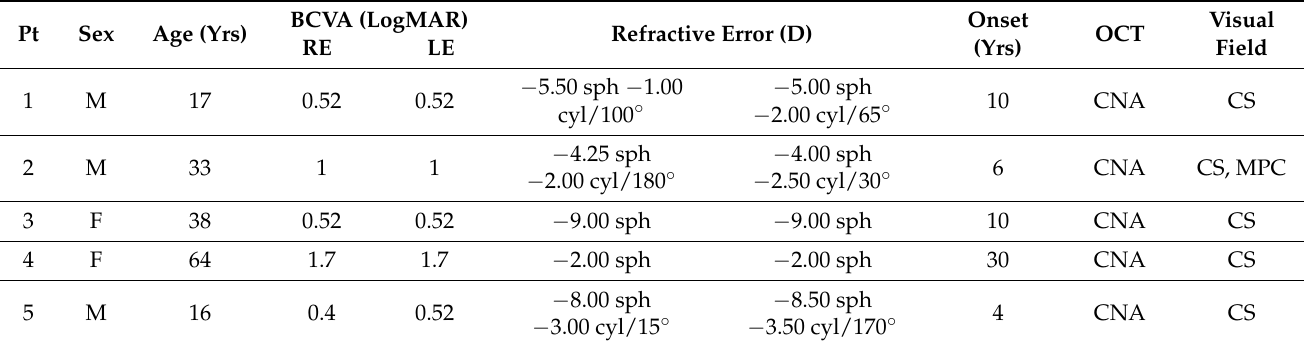
Table 1. Demographic and clinical data of patients.